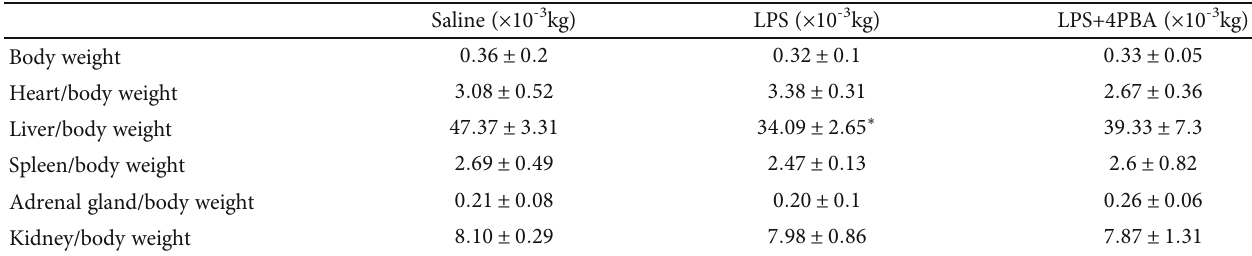
Adrenal gland/body